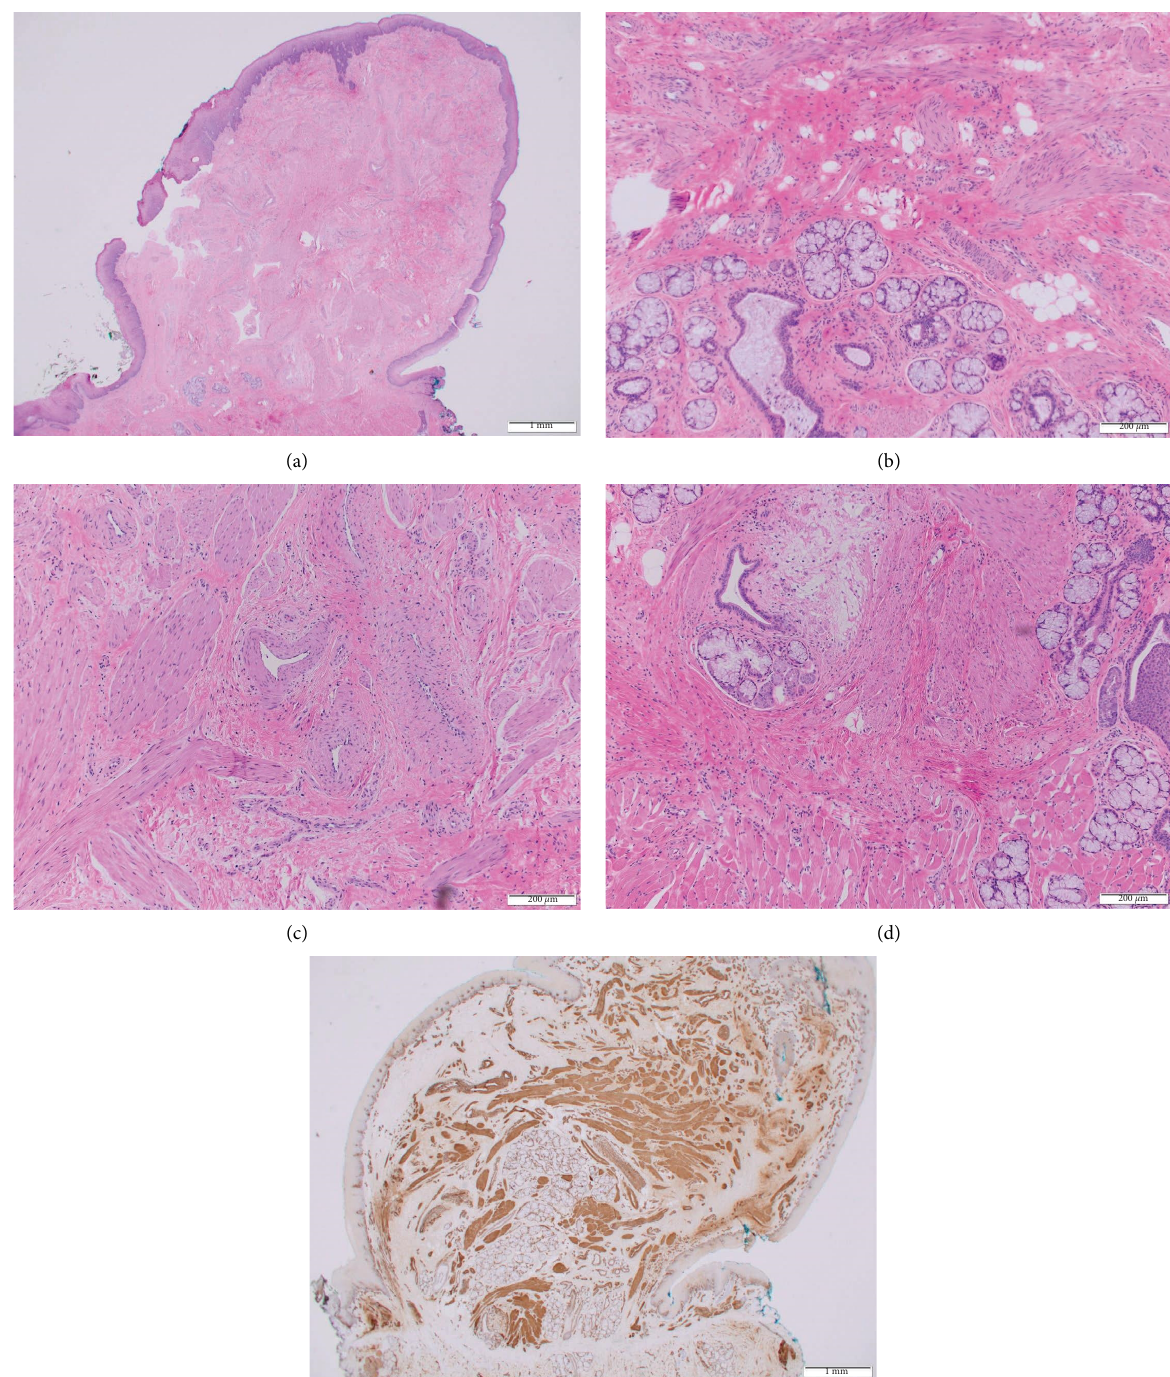
Figure 3: (a) An histological section of lingual mass demonstrating a raised, broad-based polypoid lesion covered with stratified keratinizing epithelium with a central core of smooth muscle (hematoxylin and eosin stain, 2x original magnification). (b) An histological section of lingual mass demonstrating smooth muscle with the salivary gland and duct tissue with intervening adipocyte clusters (hematoxylin and eosin stain, 10x original magnification). (c) An histological section of lingual mass demonstrating smooth muscle with small, thick-walled vessels present (hematoxylin and eosin stain, 10x original magnification). (d) An histological section of lingual mass demonstrating transition between smooth muscle of leiomyomatous lesion and skeletal muscle of dorsal tongue (hematoxylin and eosin stain, 10x original magnification). (e) An histological section of lingual mass with smooth muscle actin stain (2x original